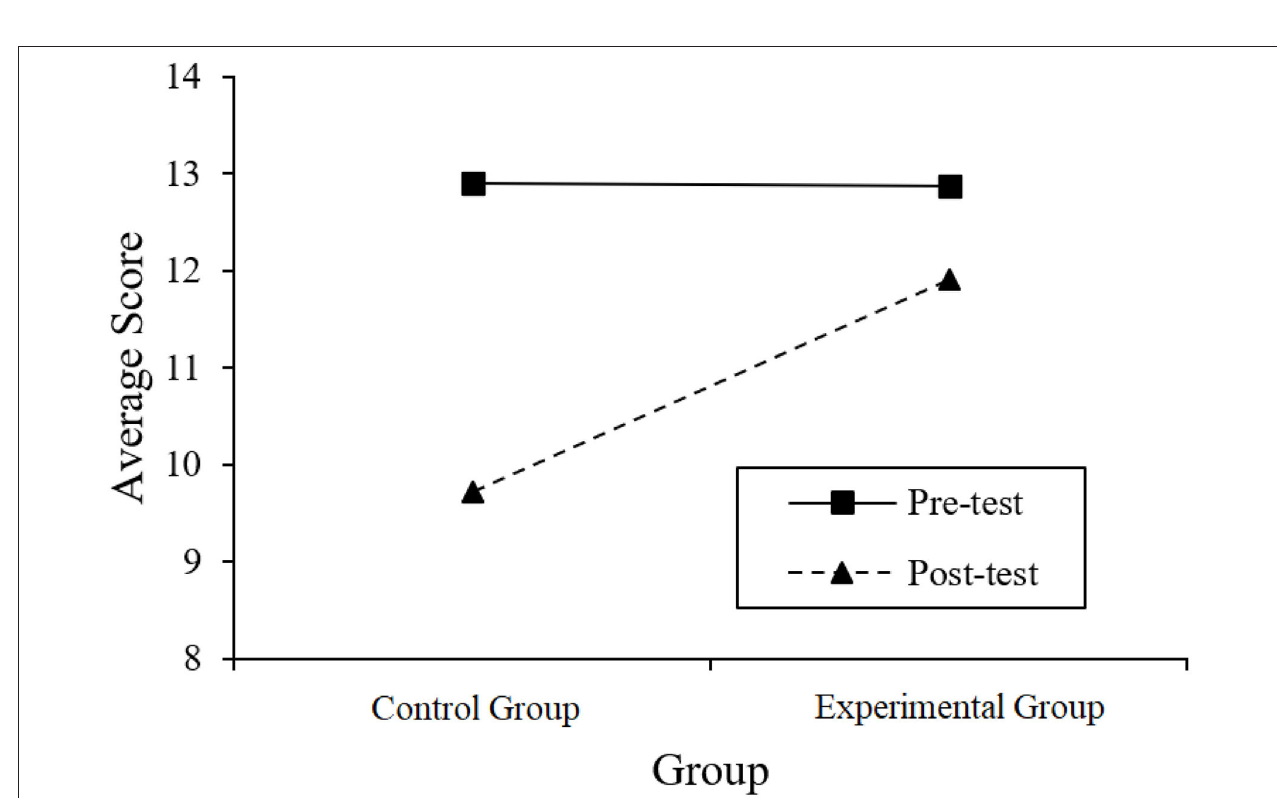
FIGURE 2 | The illustration of time × group